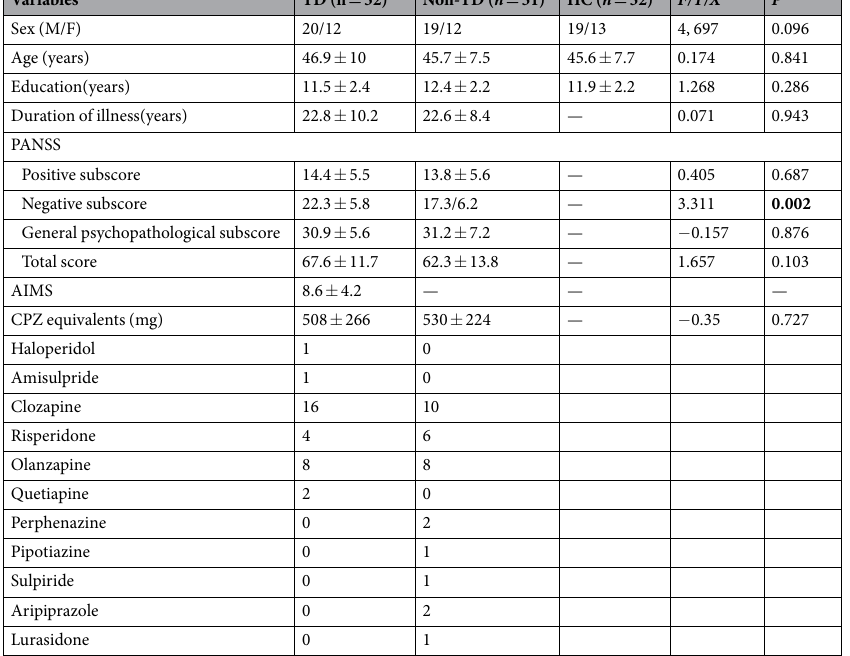
Table 1. Demographic and clinical characteristics. p -value indicate significant differences ( p < 0.05) in appropriate statistical tests. PANSS: positive and negative syndrome scale; AIMS: Abnormal Involuntary Movement Scale; CPZ: chlorpromazine; TD: patients with schizophrenia and tardive dyskinesia; non-TD: patients with schizophrenia and without tardive dyskinesia; HC healthy